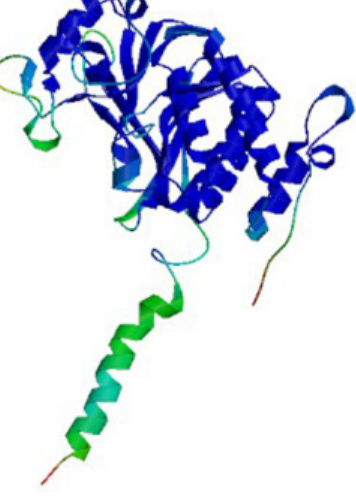
Figure 4. The 3D structural model of Tianfu goat PPP3CA (1–352 AA) based on homology